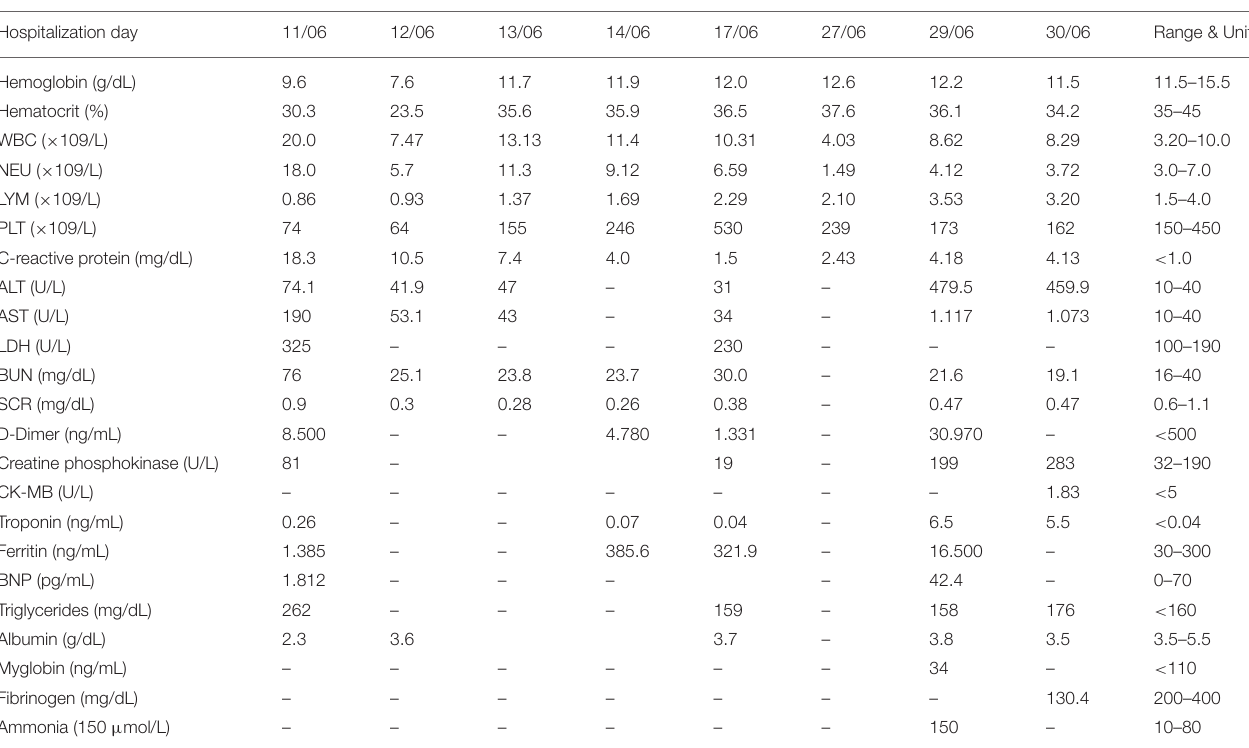
TABLE 1 | Clinical laboratory results during the current